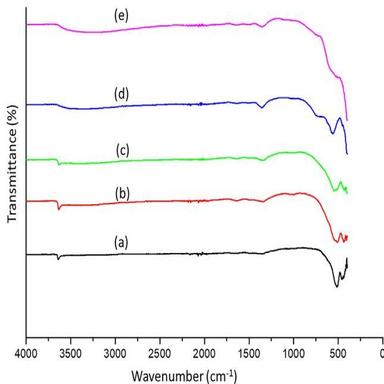
FTIR spectra of (a) Ni(OH)2, (b) Ni0.95Mn0.05(OH)2, (c) Ni0.9Mn0.1(- OH)2, (d) Ni0.75Mn0.25(OH)2 and (e) Ni0.5Mn0.5(OH)2.